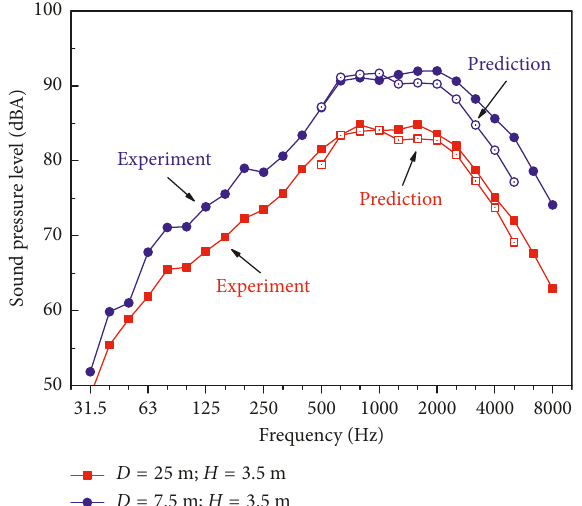
Figure 15: Frequency characteristics of the predicted and mea- sured pass-by noises at 350km/h.